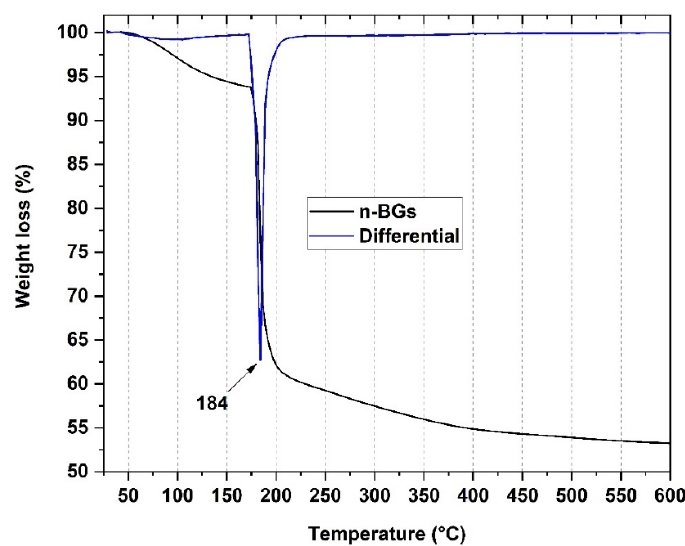
Figure 3. Thermogravimetric analysis of the n-BGs.